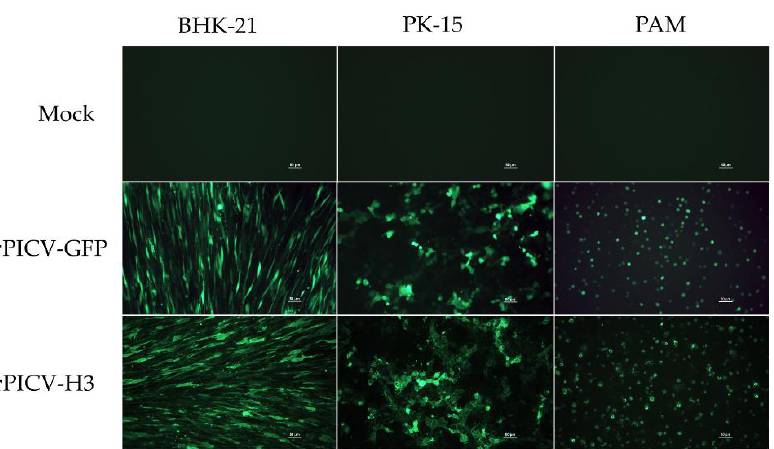
Figure 2. Expression of genes-of-interest. BHK-21, PK-15, and PAMs were infected with either rPICV-GFP or rPICV-H3 viruses at an MOI of 1 pfu per cell. At 48 hpi, GFP images were taken directly from cells infected with the rPICV-GFP virus. On the other hand, IFA was performed to detect expression of HA protein in cells infected with the rPICV- H3 virus. Bar = 100 μM.